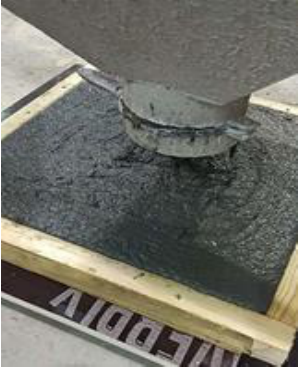
Figure 2. Plate casting direction.